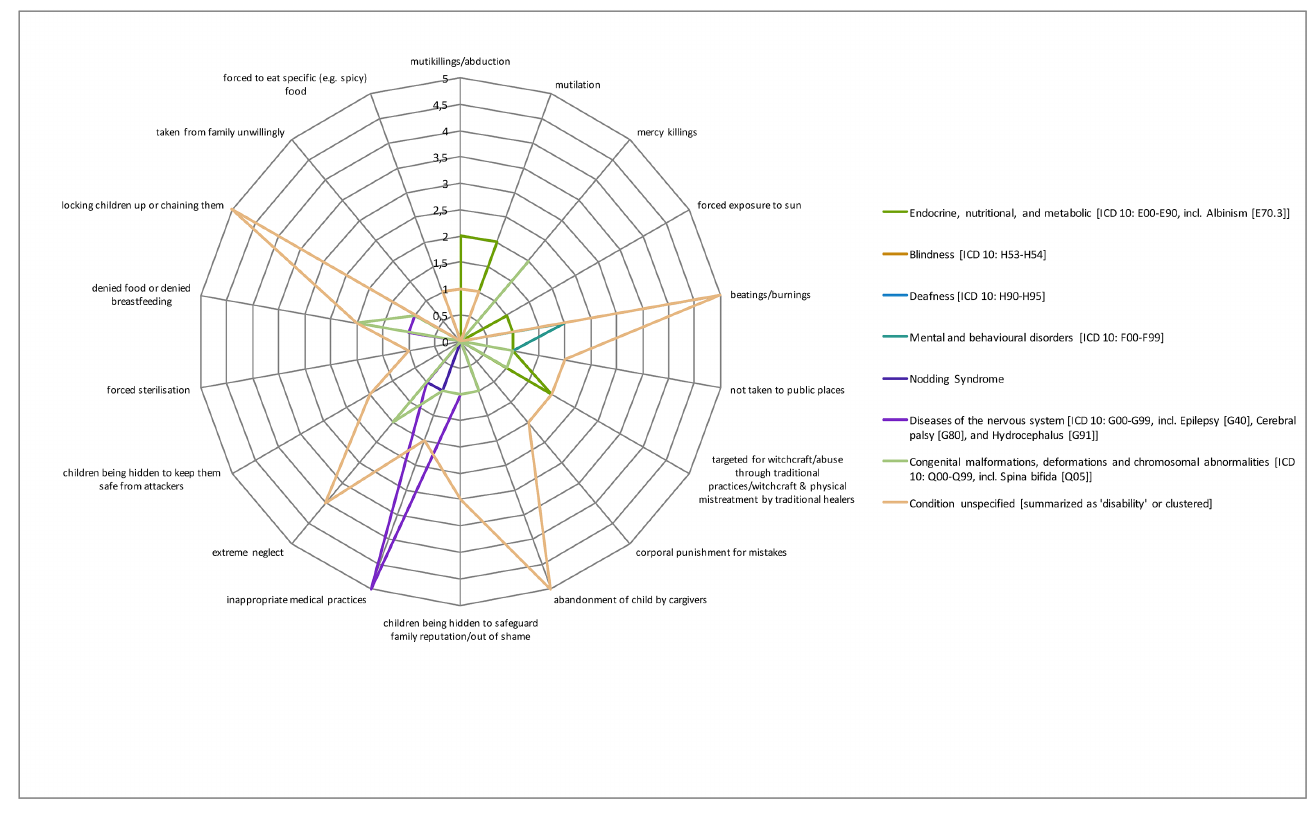
Fig 5. Evidence of physical abuse by type of disability.